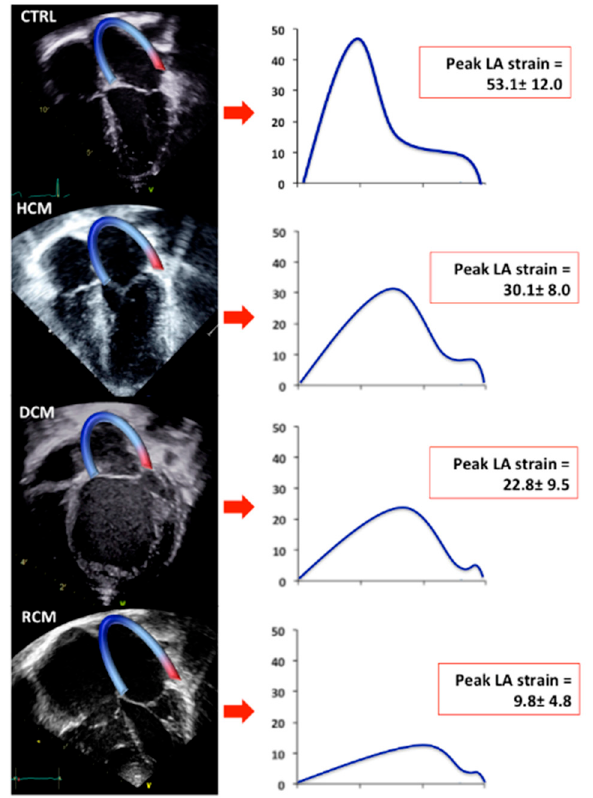
Figure 2. Speckle Tracking Analysis of Left Atrial Strain in the study population. Apical 4-chamber views of CTRL, HCM, DCM and RCM with the endocardium of the LA traced ( left ). On the ( right ), LA strain curves are depicted as mean of each studied group (blue curves). CTRL: normal controls. HCM: Hypertrophic Cardiomyopathy. DCM: Dilated Cardiomyopathy. RCM: Restrictive Cardiomyopathy. LA: Left Atrial.